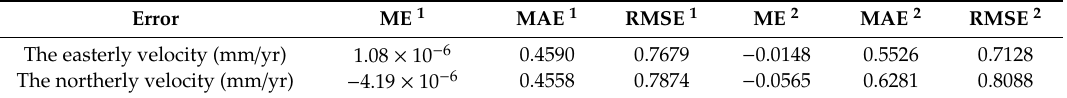
Table 3. Direct verification and cross-verification of speed error